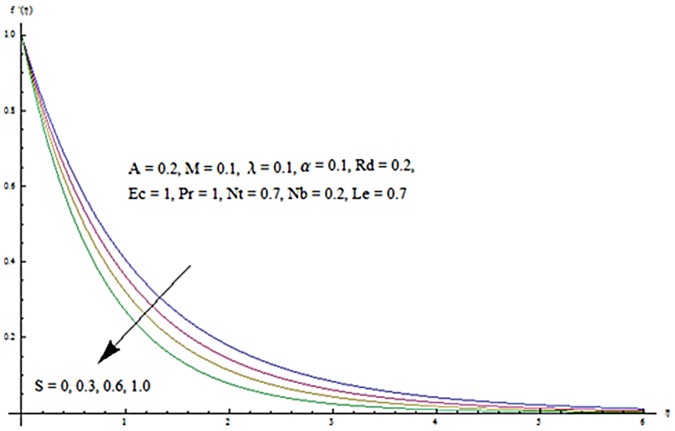
Influence of S on f′.